Question: Give a one-sentence summary of this figure.
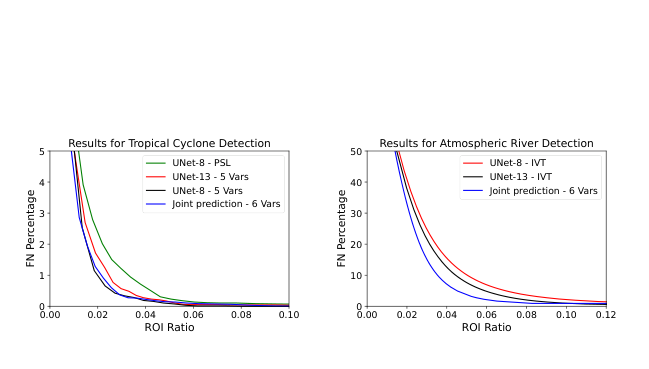
Answer: ROI ratio versus false negative ratio curve for TC and AR. These results show that a NN-based prediction approach for both TC and AR can achieve close to zero false negatives while keeping the ROIs to be less than 12 percent.